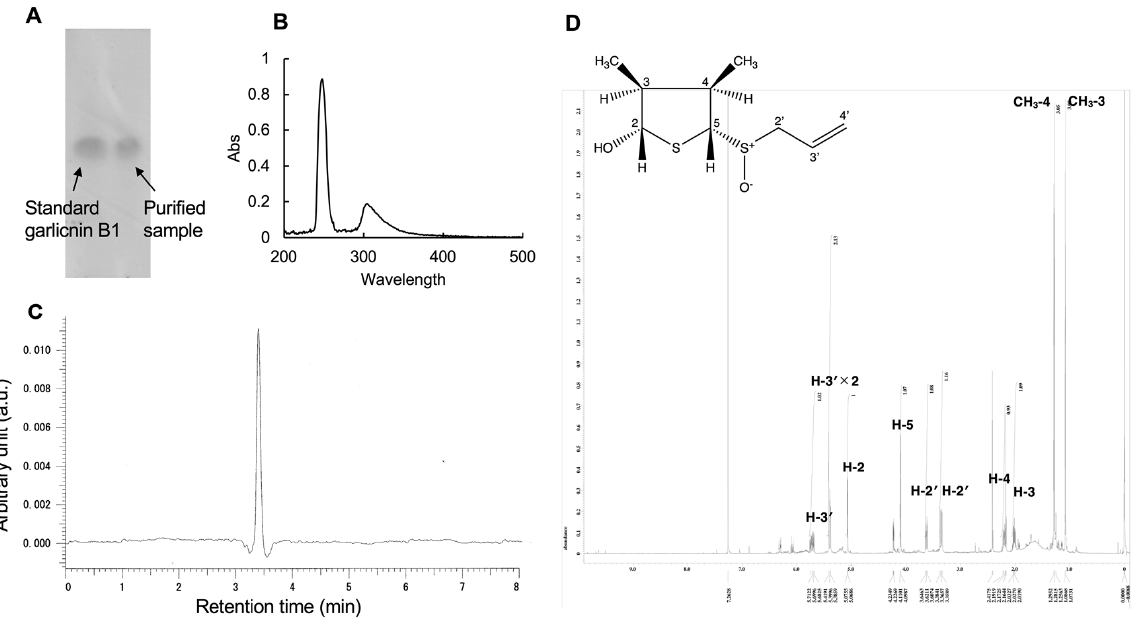
Figure 1. Thin-layer chromatography (TLC) ( A ), UV-vis spectra ( B ), high-performance liquid chro- matography (HPLC) ( C ), and 1 H-NMR spectra ( D ) of garlicnin B1. The TLC analysis showed a single dot, indicating that the garlicnin B1 was relatively pure. In the HPLC analysis, a single peak was observed, indicating the high purity of the compound. 1 H-NMR spectra were recorded in the CDCl 3 solution with chemical shift expressed with tetramethyl silane (TMS) as the internal standard. The chemical shift ( δ ) was reported in parts per million (ppm), and the following abbreviations indicate the J value in Hz and the signals: s: singlet, d: doublet, t: triplet, m: multiplet, dd: double doublet, br: broad. The Inset of ( D ) shows the speculated chemical structure of